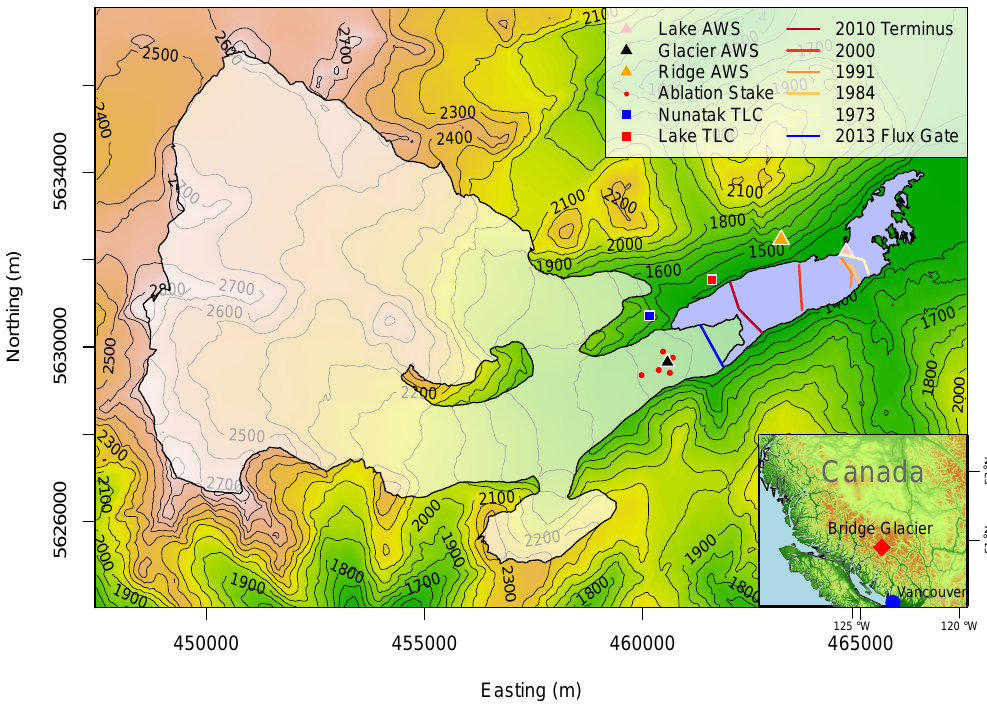
Figure 1. Bridge Glacier study area, instrumentation, and select terminus positions from 1973 to 2013. The DEM is from winter 2006 and contour intervals are 100m. The 2013 end-of-season snow line was 2103m. Insert shows the location of Bridge Glacier within southwest British